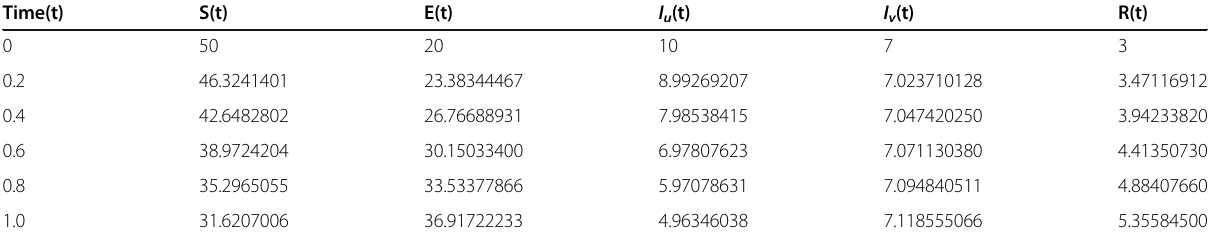
Table 2 Numerical results of the model system equations using Runge-Kutta method Time(t)